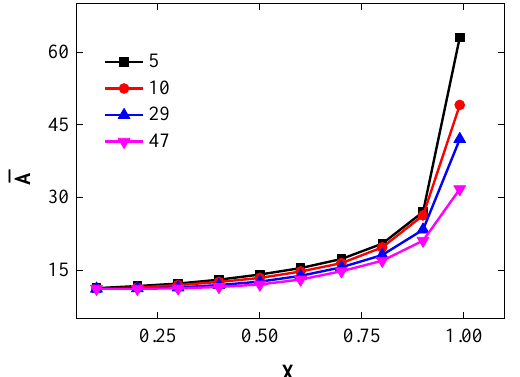
Figure 10. Plot of